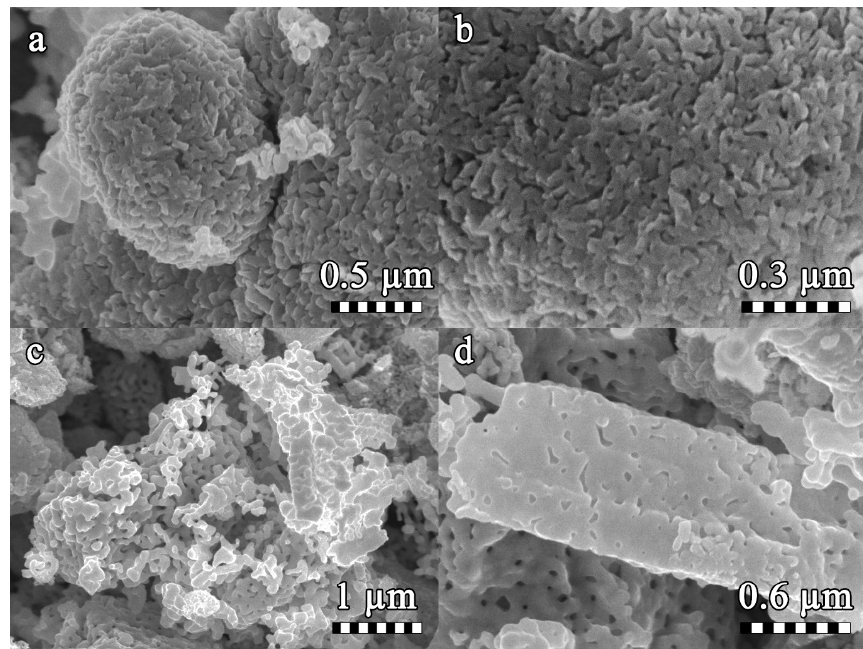
Figure 5. SEM images of sample heat-treated at 740 °C in 100 mL/min 20% N 2 /H 2 flow. Magnification: ( a ) × 72,000 ( b ) × 143,000 ( c ) × 36,000 ( d ) × 72,000